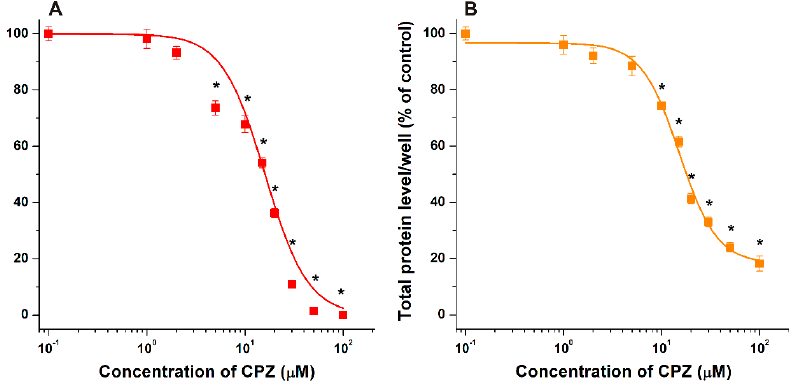
Figure 3. Effects of increasing concentrations of CPZ (0.10, 1.0, 2.0, 5.0, 10, 15, 20, 30, 50, and 100 µM) on the cellular ATP ( A ) and total protein ( B ) levels of SH-SY5Y cells after 24 h incubation. Means ± SEM values are demonstrated ( n = 3, * p < 0.01; see further experimental details in Section 2.2).